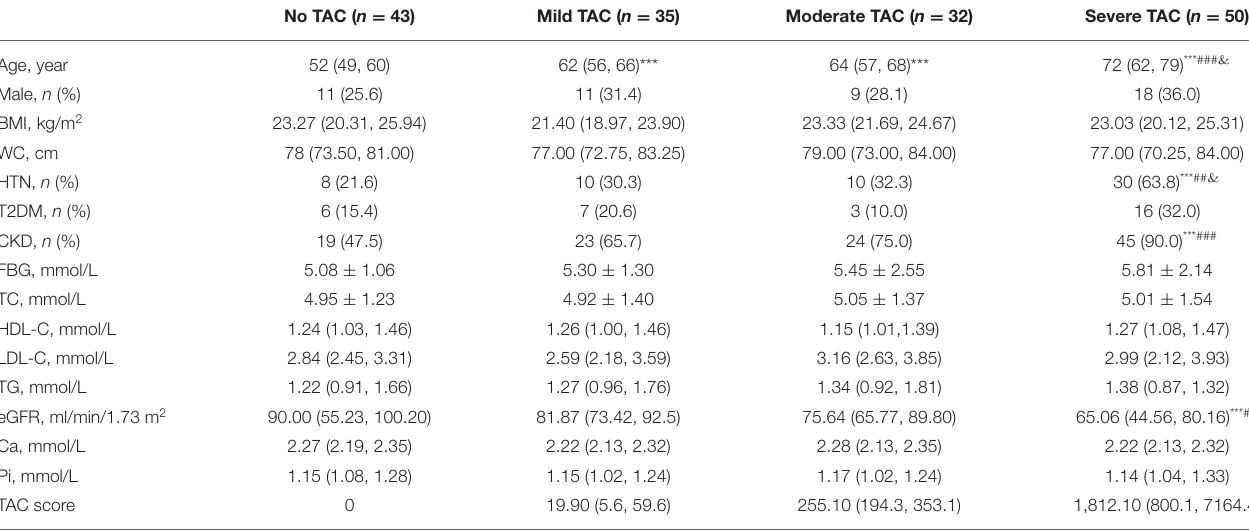
TABLE 1 | Clinical characteristics of all participants according to different severities of TAC.